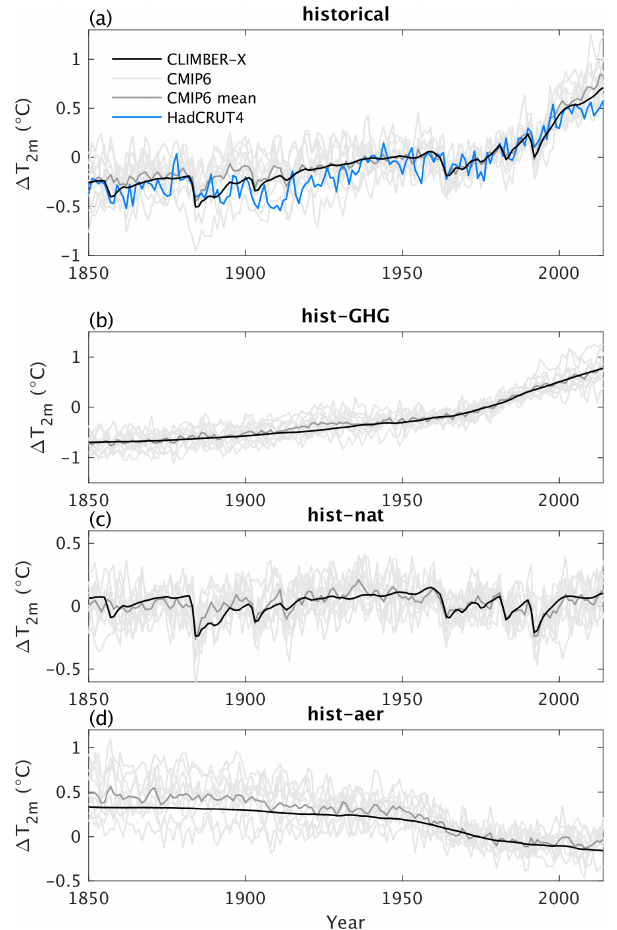
Figure 19. (a) Historical global mean near-surface air temperature simulated by CLIMBER-X (black) compared to observations (blue) (Morice et al., 2012) and CMIP6 models (grey). (b–d) Global mean near-surface air temperature in CLIMBER-X and CMIP6 models for idealized historical simulations with greenhouse gas concen- tration forcing only, natural (solar and volcanic) forcing only, and aerosol forcing only, respectively.